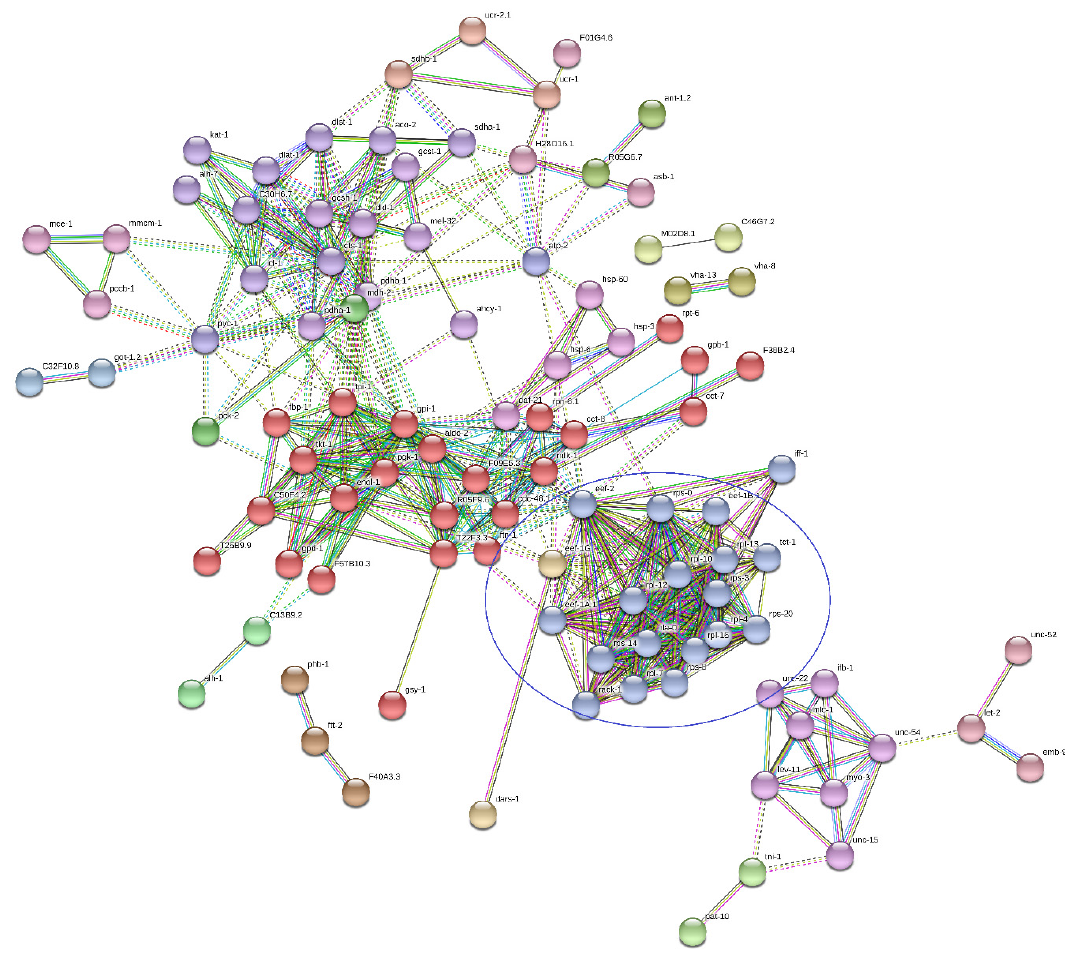
Figure 10. Network analysis of sample B LC . The highlighted blue cluster is related to ribosomal proteins.